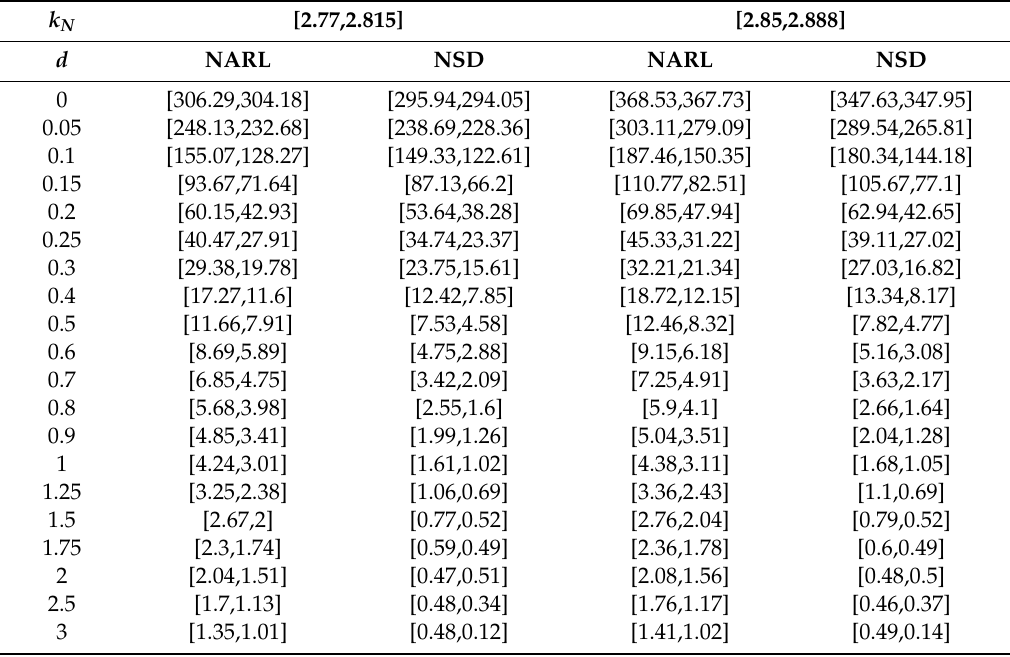
Table 2. The values NARL and NSD when n N (cid:15) [ 3,5 ] and λ N (cid:15) [ 0.18,0.22 ] .